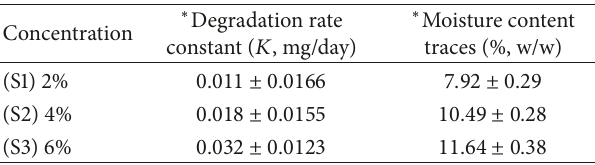
Table 2: Rate of degradation constant (mg/day) and moisture content (%) of the 3D scaffold infused with different carrageenan